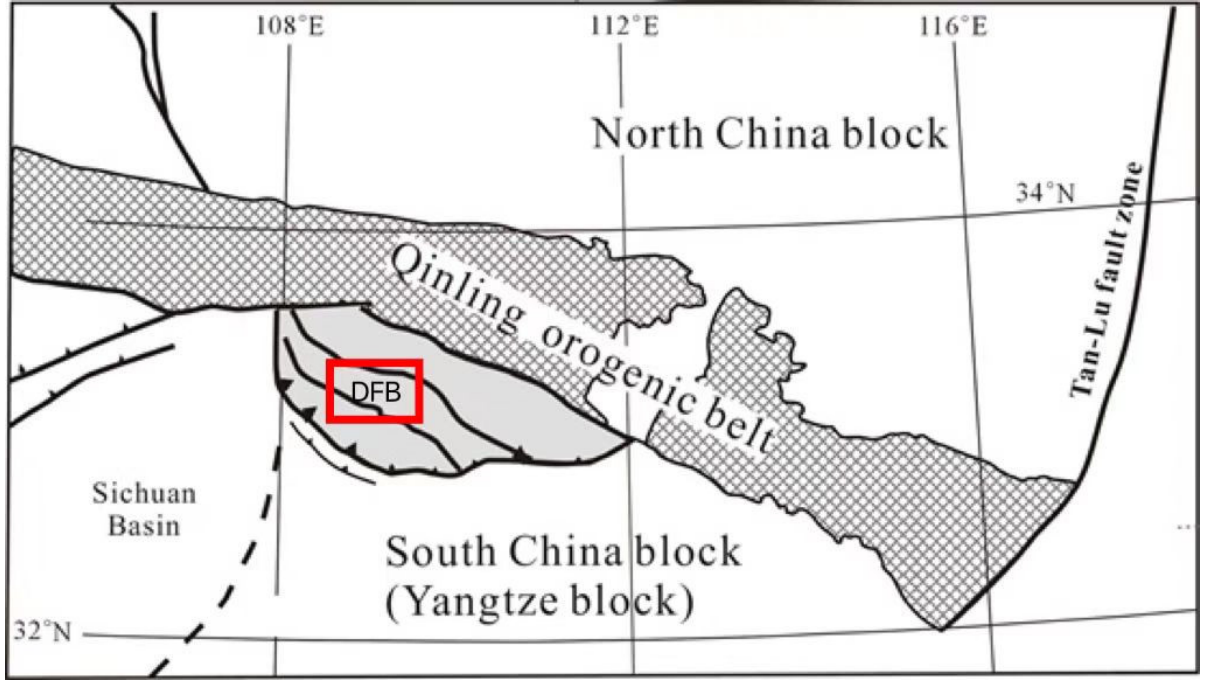
Figure 1. Geotectonic location map of the study area.